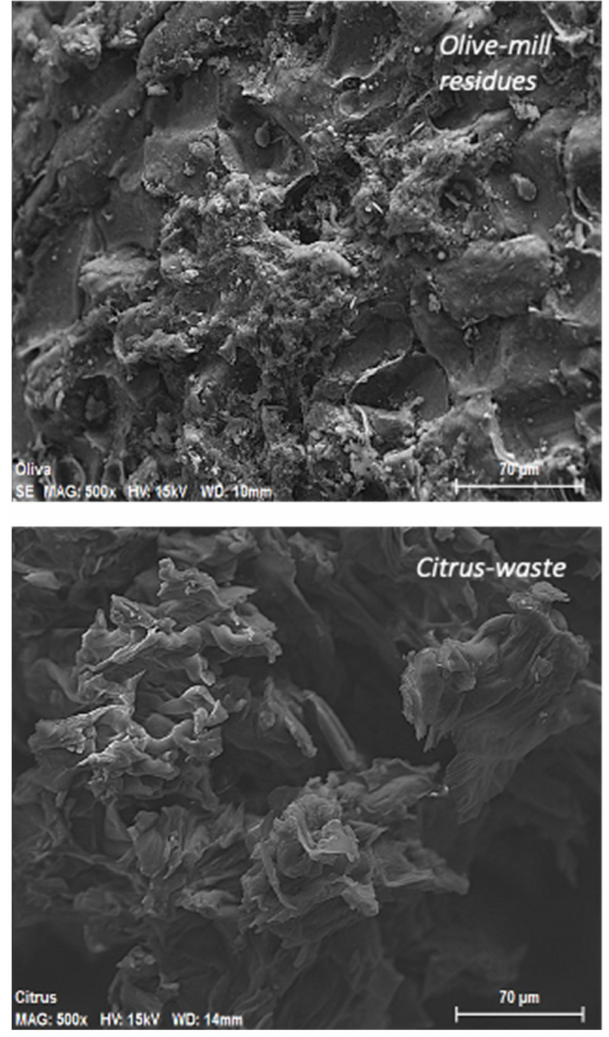
Figure 1. Scanning electron micrographs of the powder